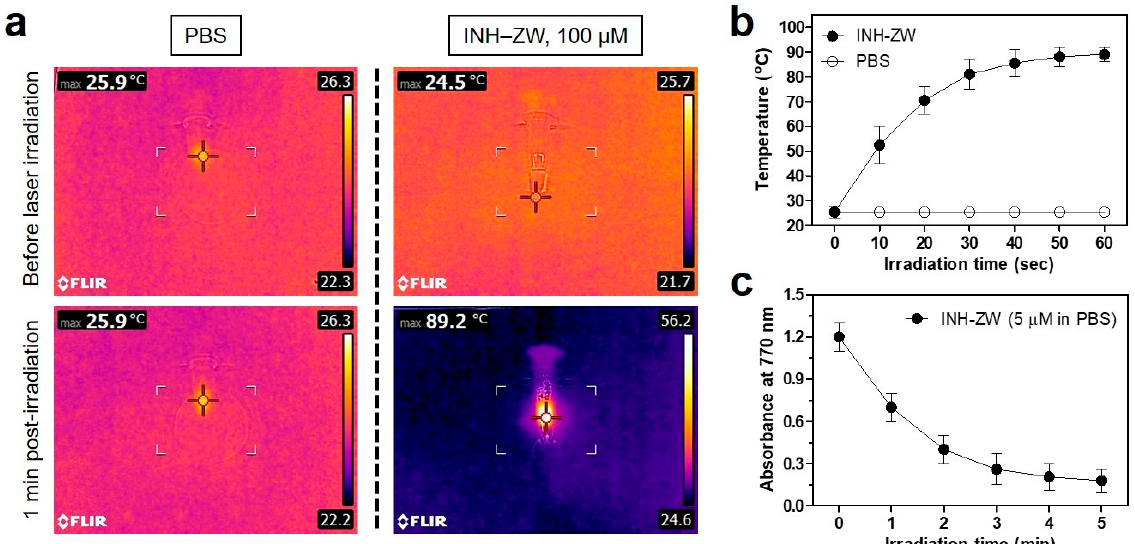
Figure 5. ( a ) In vitro thermal images of the INH–ZW solution (10 µ g/100 µ L in PBS; 100 µ M concentration is equivalent to a single dose of 0.4 mg/kg) and PBS alone (100 µ L) exposed to an 808 nm laser (1.1 W/cm 2 ) for 1 min. The maximum temperature was automatically recorded using an infrared thermal camera as a function of the irradiation time. ( b ) Temperature changes in the solutions in each sample were monitored during the 1 min of laser irradiation. ( c ) Photostability of the INH–ZW solutions under laser irradiation. The absorbance changes in 5 μ M INH–ZW solutions were measured at 770 nm during the 5 min of laser irradiation. Data are expressed as the mean ± S.D. of three independent experiments.